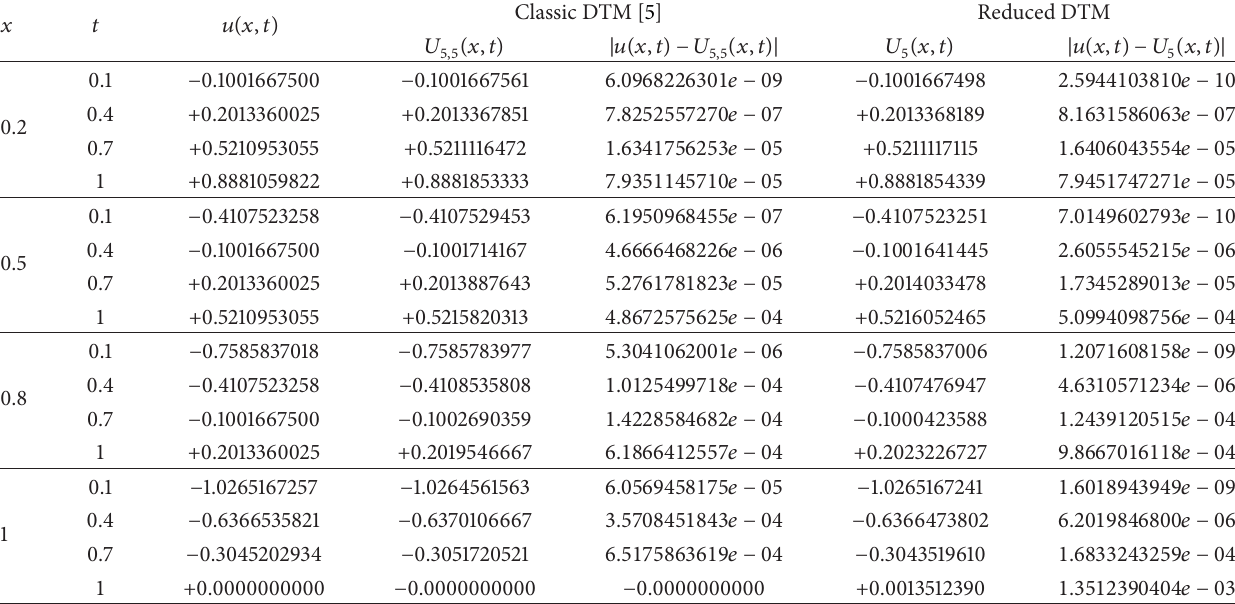
Table 5: Comparisons of the exact solution 𝑢(𝑥,𝑡) = sinh (𝑡−𝑥) , with 𝑈 5,5 (𝑥,𝑡) obtained by classic DTM [5] and 𝑈 5 (𝑥,𝑡) obtained by reduced DTM at some test points (𝑥,𝑡) in Example